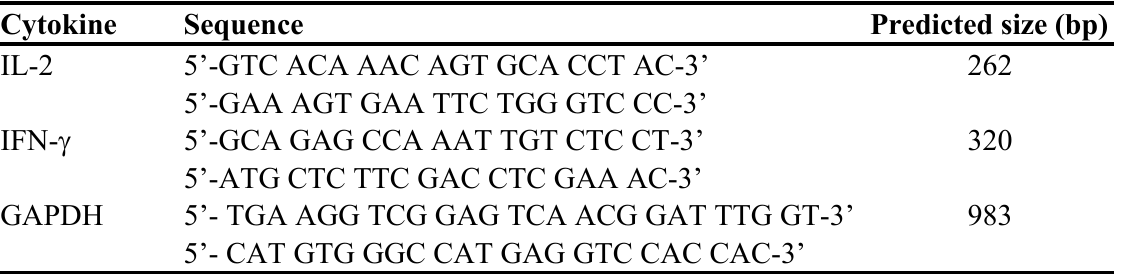
Table 1. Oligonucleotide sequences of the primers used for amplification of IL-2 and IFN- γ in